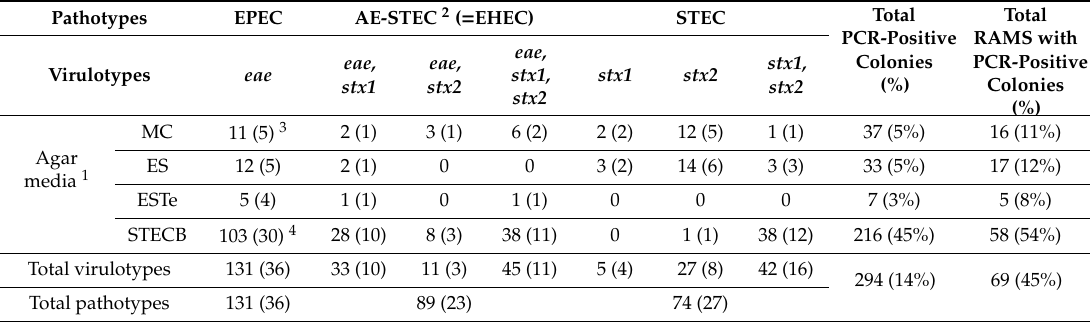
Table 5. Pathotypes and virulotypes of the triplex PCR-positive colonies according to the agar media.